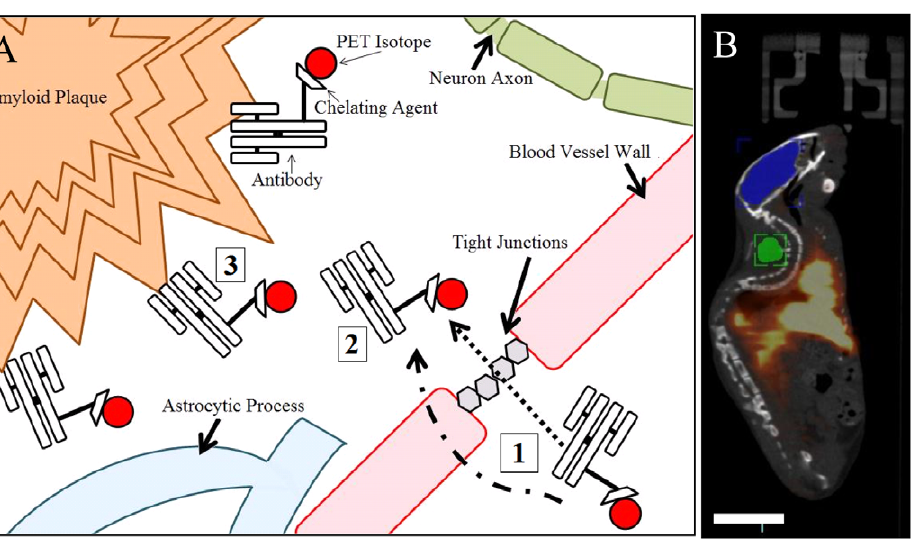
Figure 1. Antibody modification with a Copper chelator and positron emitter 64 Cu allows quantification of contrast agent accumulation in the brain using Positron Emission Tomography. (A) A schematic of the imaging strategy design highlighting the antibody, copper chelator (1,4,7,10-Tetraazacyclododecane-1,4,7,10-tetraacetic acid mono (N-hydroxysuccinimide ester), DOTA-NHS-ester) and positron emitter ( 64 Cu). Antibodies are delivered intravenously (1). Antibodies penetrate into brain tissue through intracellular and paracellular transport mechanisms and diffuse in brain tissue where they bind to A b (2). Antibodies are retained in the brain through binding to A b plaques (3). (B) Fusing the PET image with a CT image allows anatomical features to serve as a reference when drawing regions of interest. An example region of interest drawn in the brain is shown in yellow, while reference skin and muscle tissue is shown in the green region of interest. The entire brain was quantified in all experiments. Scale bar is 1.5 cm.